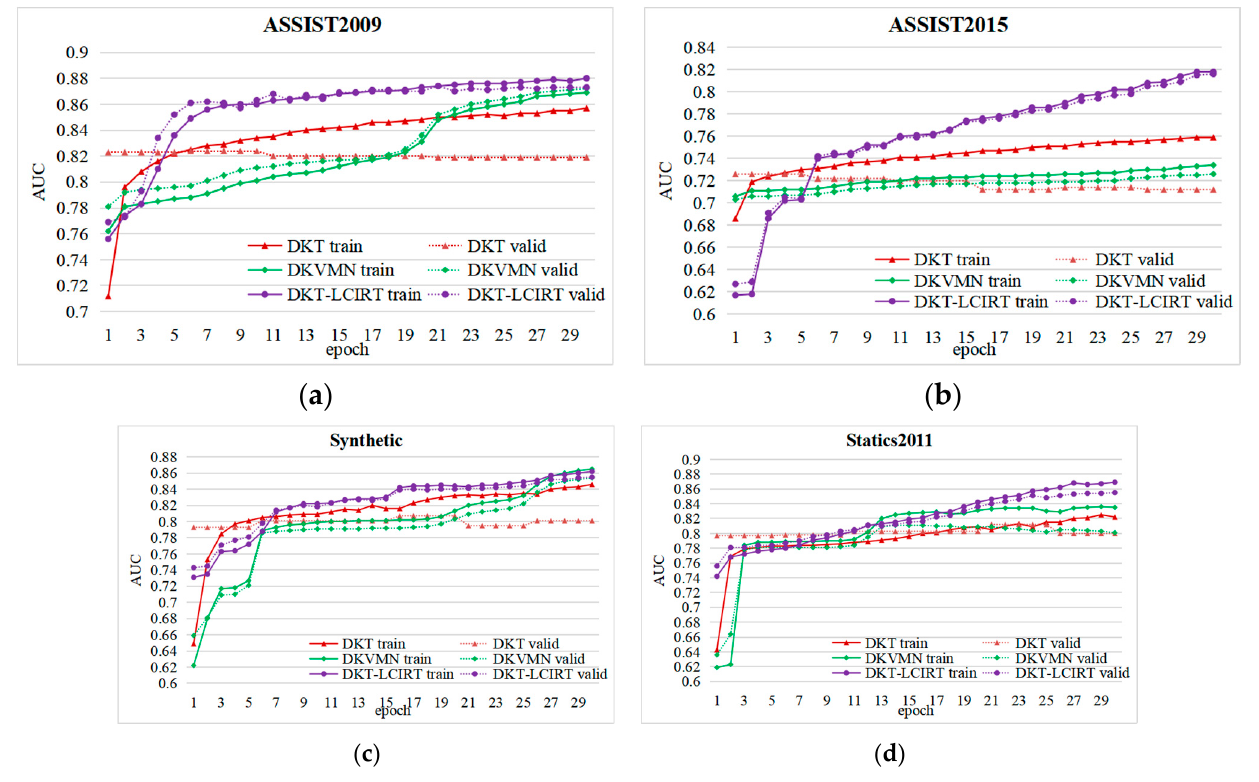
Figure 4. Training and validation AUC values for the three models on datasets ( a ) ASSIST2009, ( b ) ASSIST2015, ( c ) Synthetic, ( d )